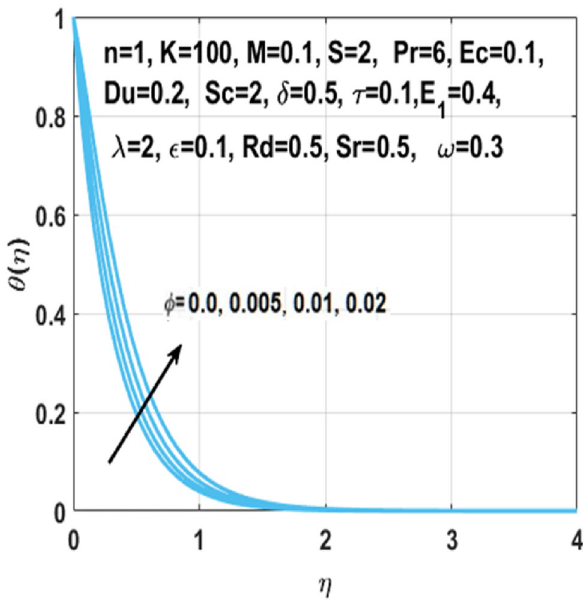
Figure 4. Impact of φ on θ(η) .